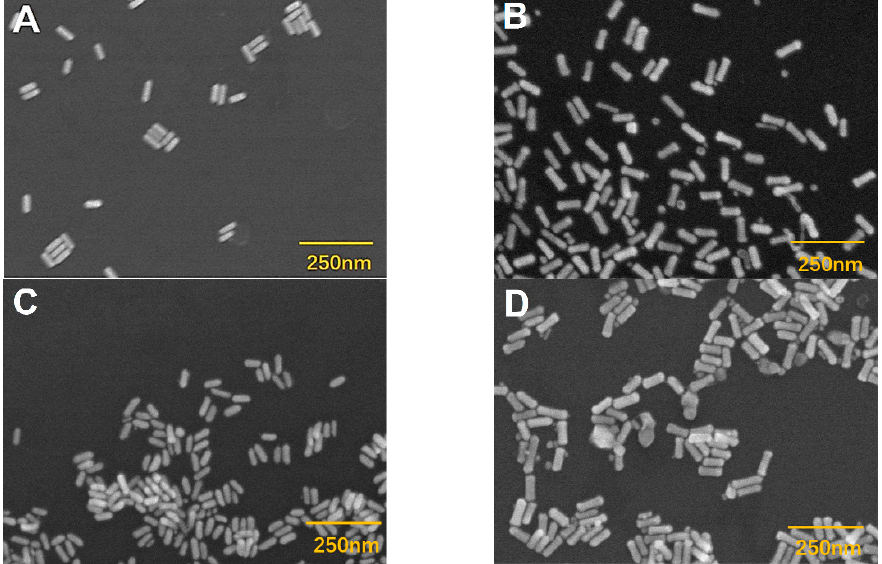
Figure 2 . Scanning electron microscopic imaging. ( A ) Gold nanorods; ( B ) silver-coated gold nanorods; ( C ) etched silver-coated gold nanorods; and ( D ) the inhibited etching of silver-coated gold nanorods by AA. Scale bar: 250 nm. Conditions: Au@Ag NRs, 50 μ L; H 2 O 2 , 450 μ M; Fe 2+ ; 0.25 mM; HCl, 0.10 M; t, 25 min; T, 45 °C; and AA, 17.5 μ M.